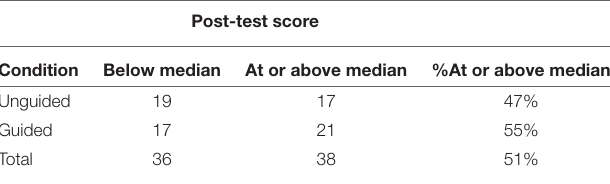
TABLE 1 | The cross-tabulation table for (Perez et al., 2017)